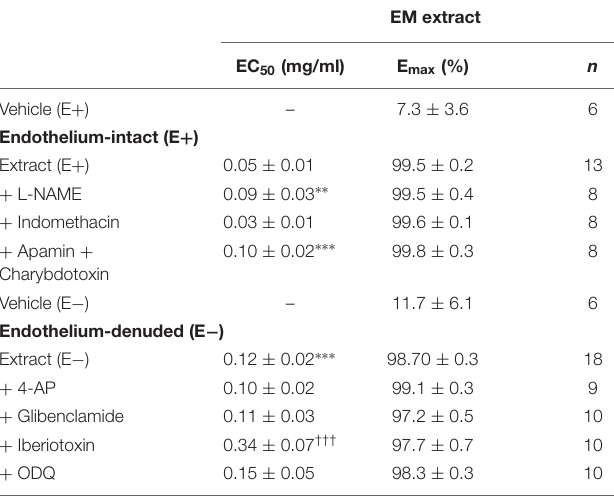
TABLE 1 | EC 50 and E max of Eulophia macrobulbon (EM) extract or 1-(4 (cid:48)